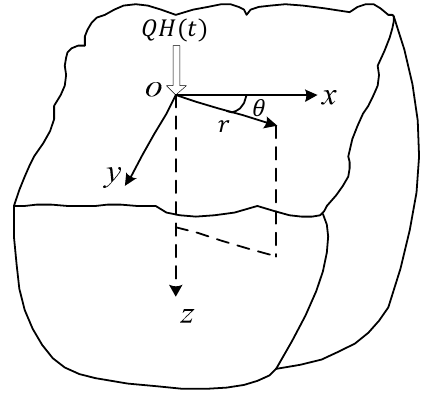
Figure 1. Isotropic and homogeneous semi-space.